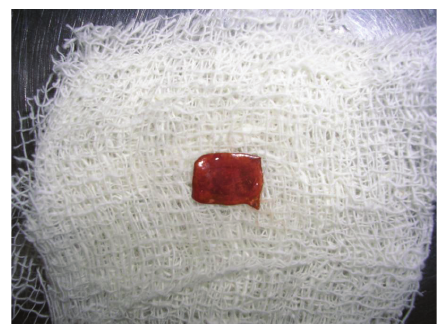
Figure 6: Removed copper strip.